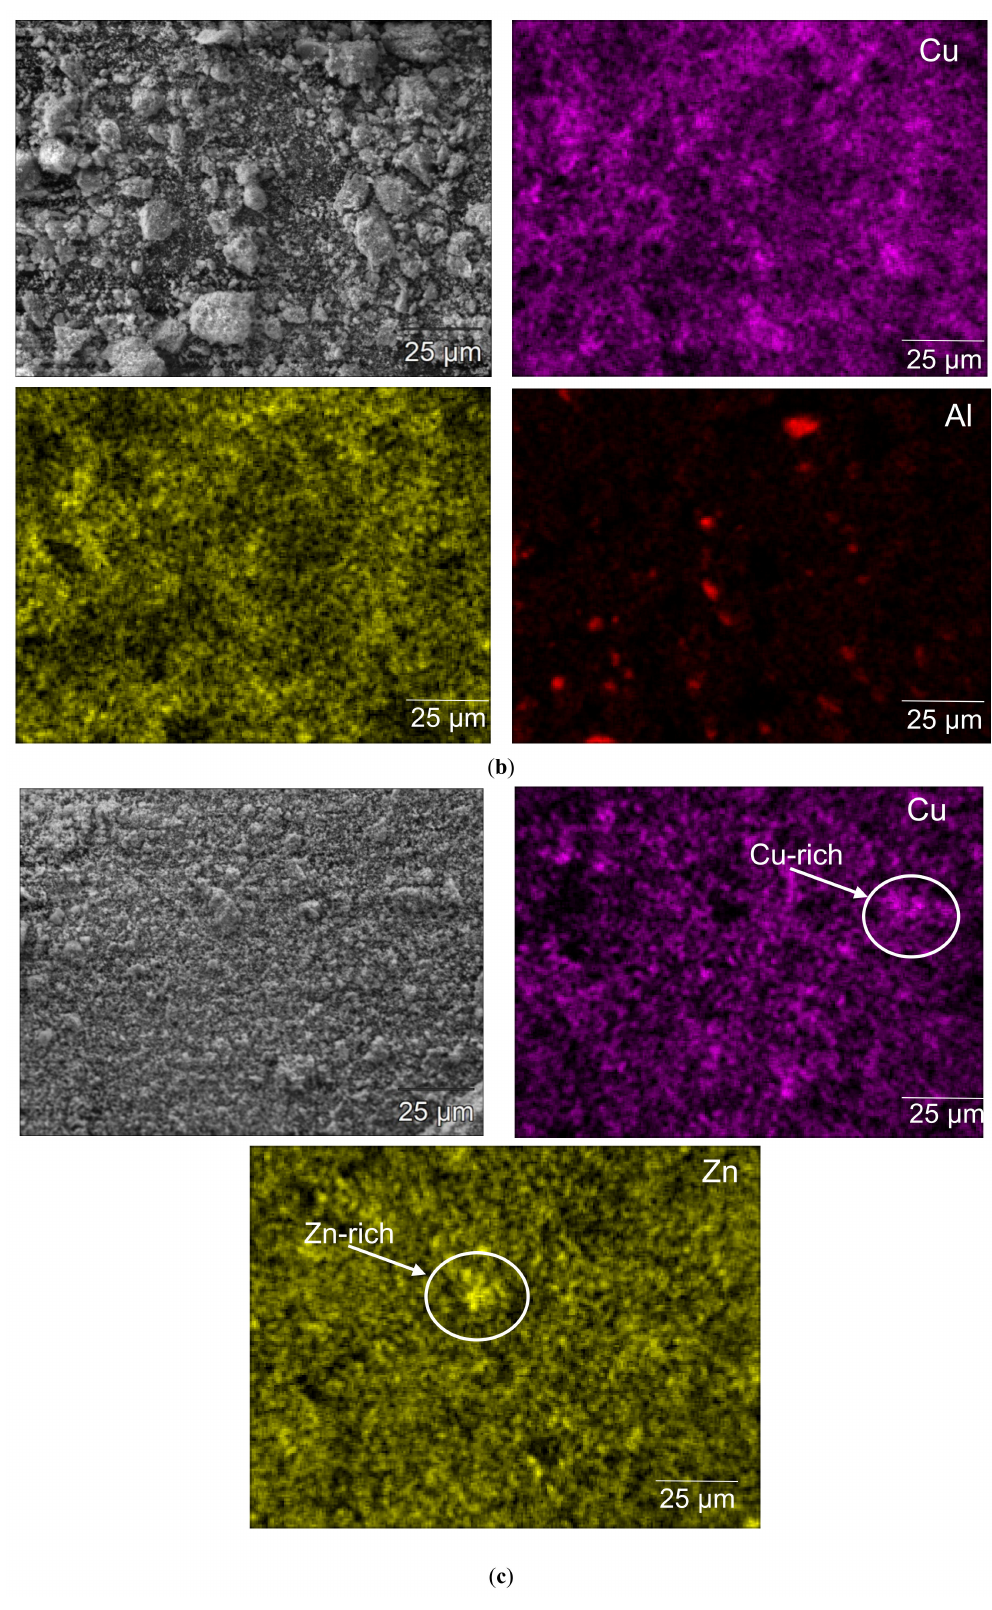
Figure 2. Scanning electron microscope-energy dispersive x-ray spectroscopy (SEM-EDX) mapping of ( a ) MET1, ( b ) MET2, ( c ) MET6 (top left: SEM picture; top right: EDX visualization of copper distribution; bottom left: EDX visualization of zinc distribution; bottom right: EDX visualization of aluminum